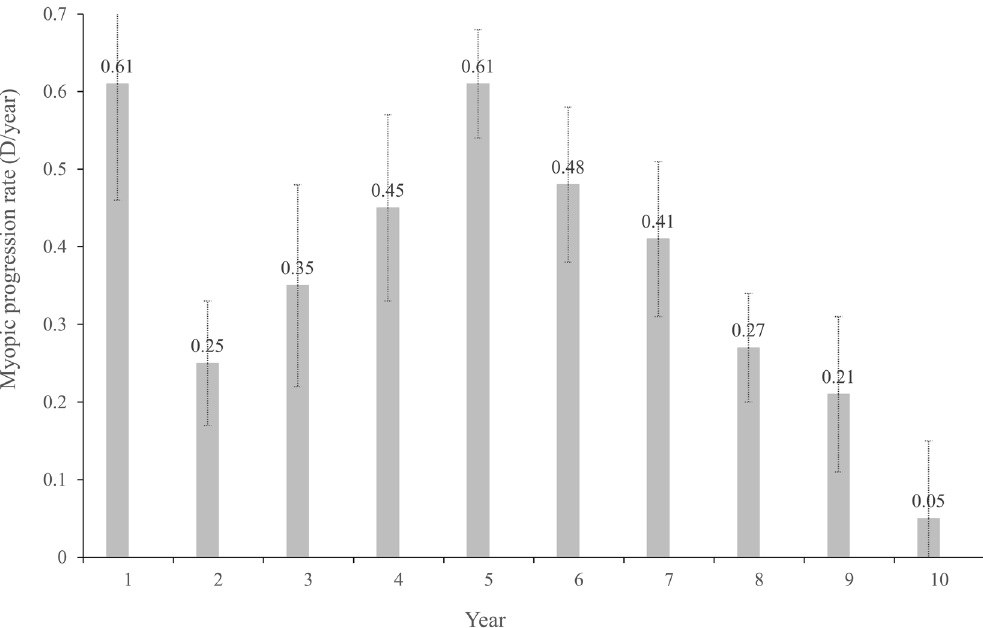
Figure. 3. Mean annual myopic progression rate with stepwise concentrations of atropine treatment. D, diopter. Bars, standard error of the